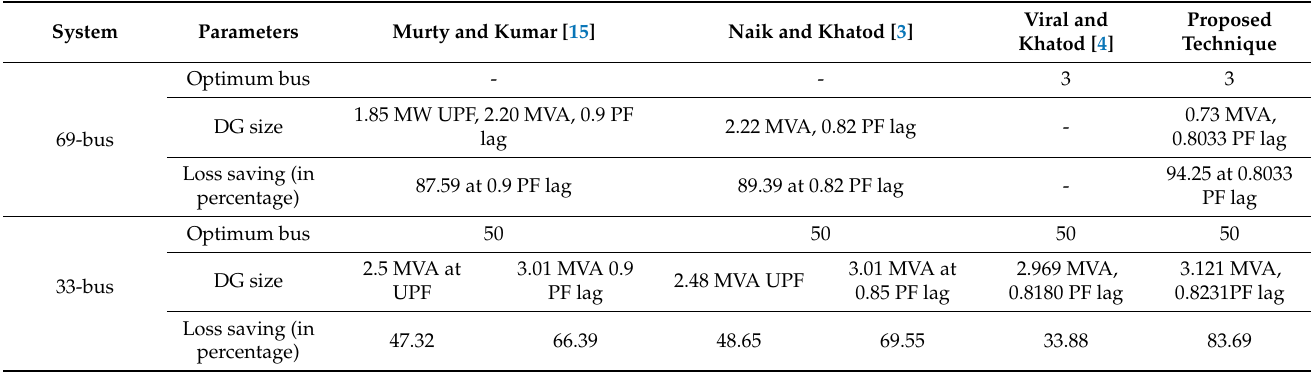
Table A5. Comparison of results by different methods for IEEE 69-bus and 33-bus radial distribu- tion system.